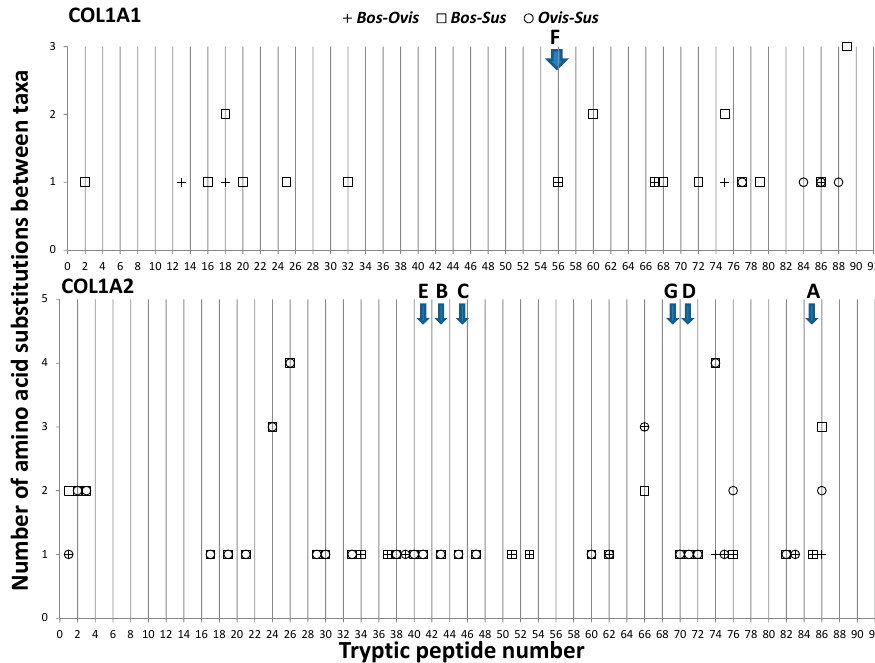
Figure 1. Plots of the number of amino acid substitutions between cattle ( Bos ), sheep ( Ovis ) and pig ( Sus ) collagen tryptic peptides for the α 1(I) ( top ) and α 2(I) ( bottom ) chains. Species biomarkers A–G presented in Buckley et al. [29] are indicated with arrows and labelled accordingly.